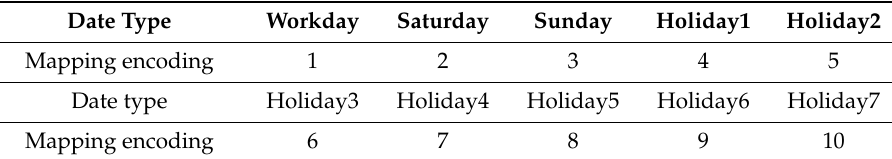
Table 1. Mapping encoding for date